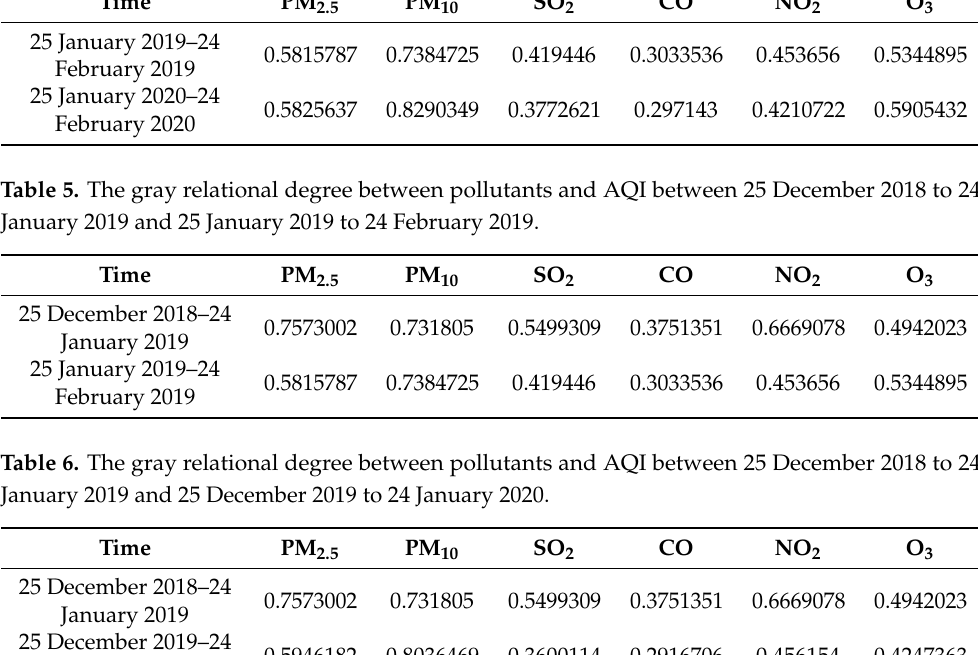
Time PM 2.5 PM 10 SO 2